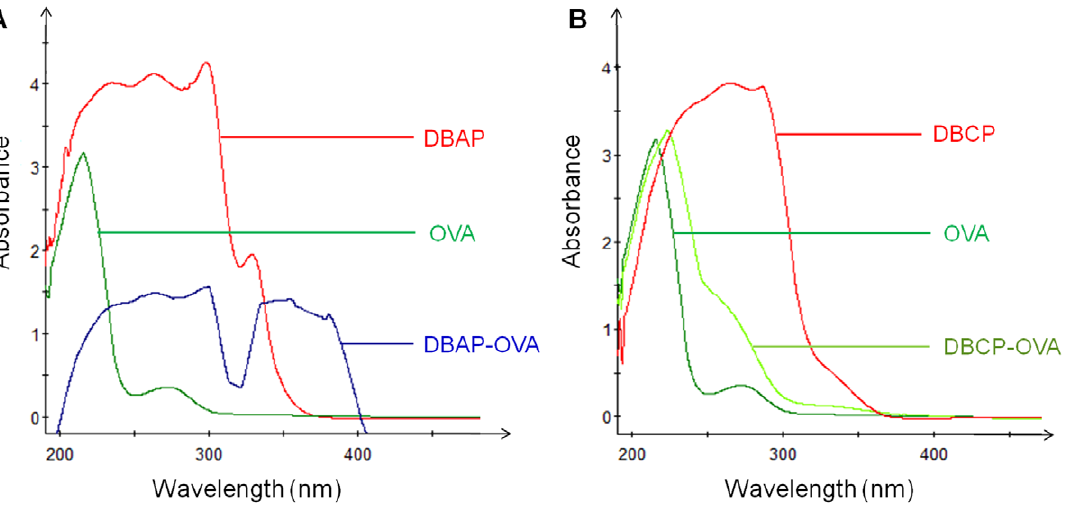
Figure 3. UV absorbance spectra of DBAP, OVA, DBAP-OVA (A) and DBCP, OVA, DBCP-OVA (B). All the concentrations of the tested substances were 0.5